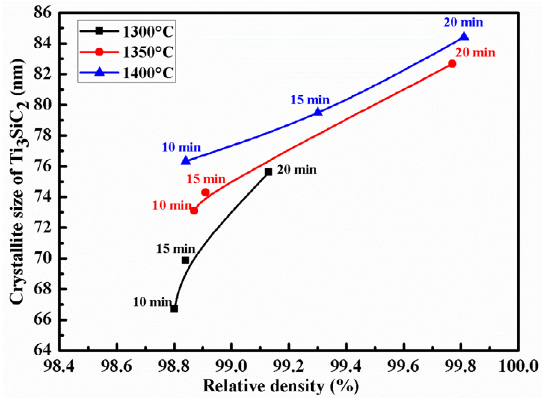
Fig. 9 Crystallite size of Ti 3 SiC 2 vs. relative density obtained from the samples sintered under 60 MPa for 10, 15, and 20 min at 1300, 1350, and 1400 ℃